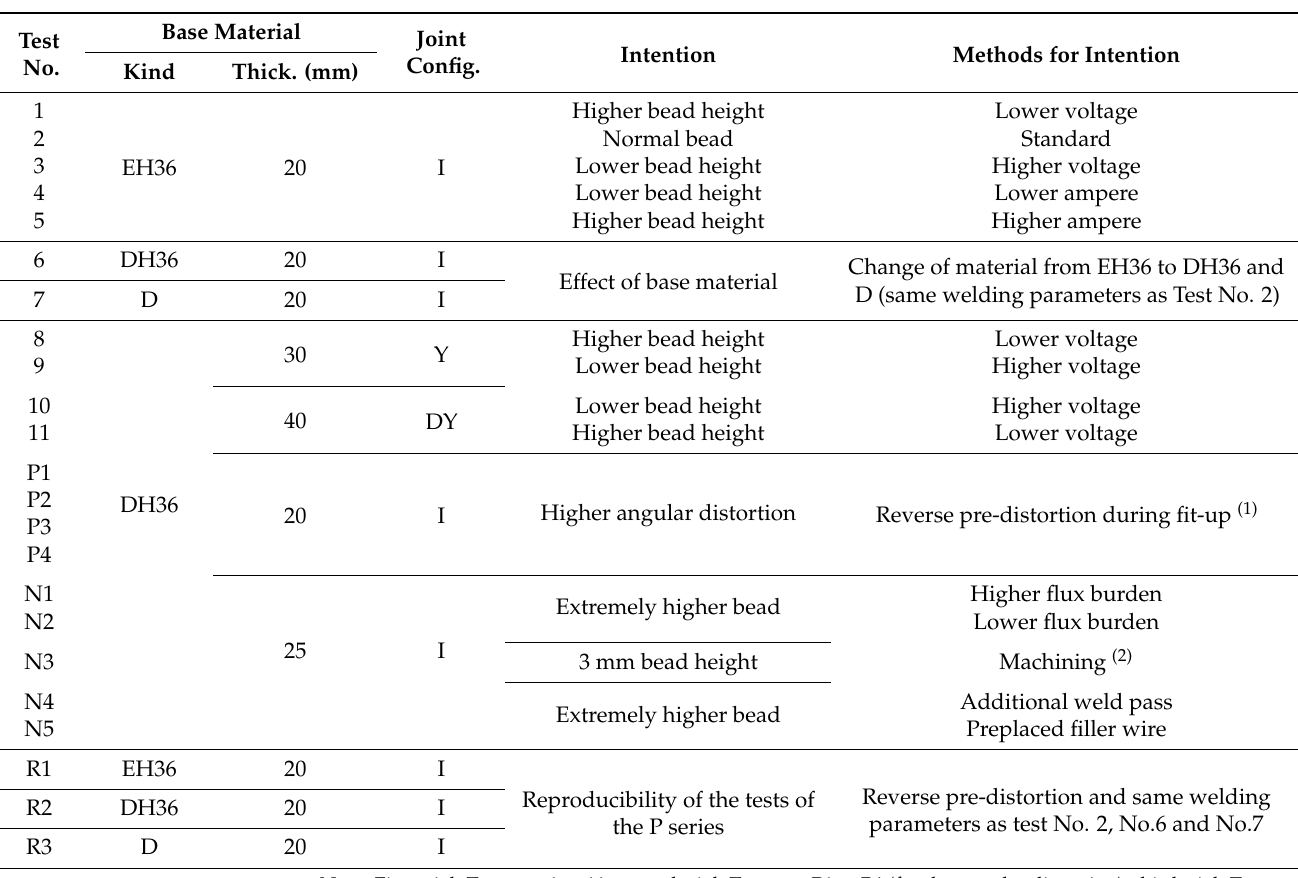
Table 1. Summary of each test number.